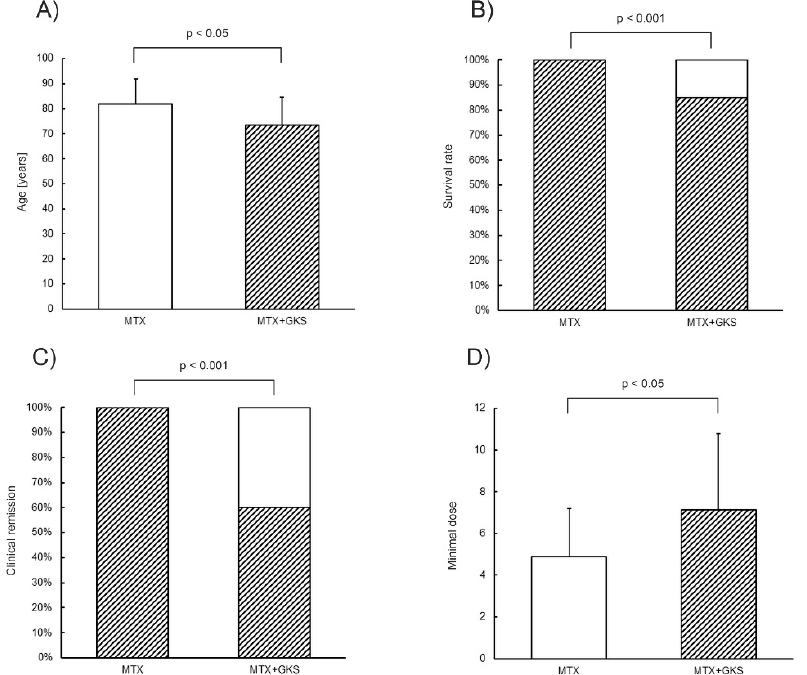
Figure 1. Comparison of Group 1 and Group 2 with regard to ( A ) age, ( B ) survival rate, ( C ) clinical remission, ( D ) minimal dose. MTX—Methotrexate, GKS—glucocorticosteroids. ( A , D ) White bar—group 1, shadow bar—group 2. The results of semiquantitative analysis are expressed as the mean ± standard deviation. The level of significance is defined where p <0.05. ( B , C ) White and shadow bar—presented feature in the group in